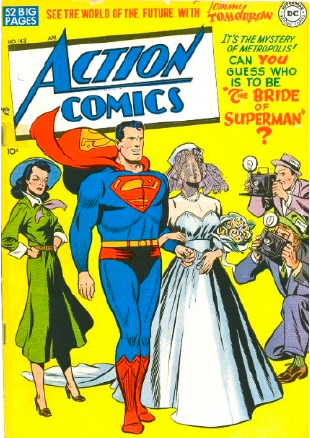
Figure 2. Action Comics #143, “The Bride of Superman” (April 1950) (In this period, women begin to appear in the different covers of the Action Comics issues, representing the sentimental as well as domestic side of Superman in the 1950s) [10] .